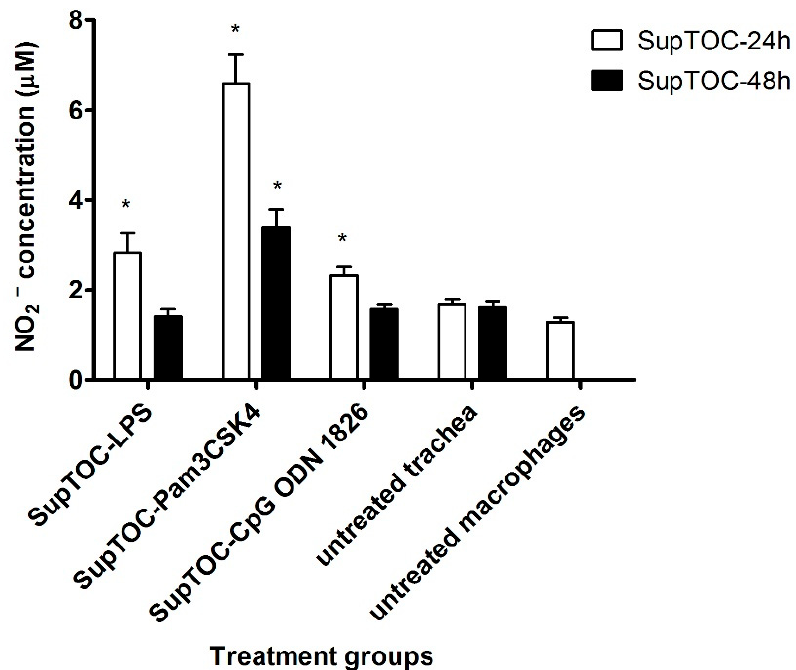
Figure 3. Nitrite oxide (NO 2 − ) production in chicken macrophage cells (MQ ‐ NCSU cell line). Chicken macrophages were stimulated with supernatants from TOCs (that were previously stimulated with TLR ligands). Nitrite oxide in MQ ‐ NCSU supernatants was measured after 48 h of stimulation, via the Griess assay. Nitric oxide production in each group was compared to the cells without stimulation using a two ‐ tailed Student’s t ‐ test. Significant differences ( p ≤ 0.05) between a test group and the group without receiving supernatant from TOC are indicated by *. SupTOC ‐ 24: culture supernatants from TOCs collected 24 h post ‐ treatment with TLR ligands or medium. SupTOC ‐ 48: culture supernatants from TOCs collected 48 h post ‐ treatment with TLR ligands or medium.